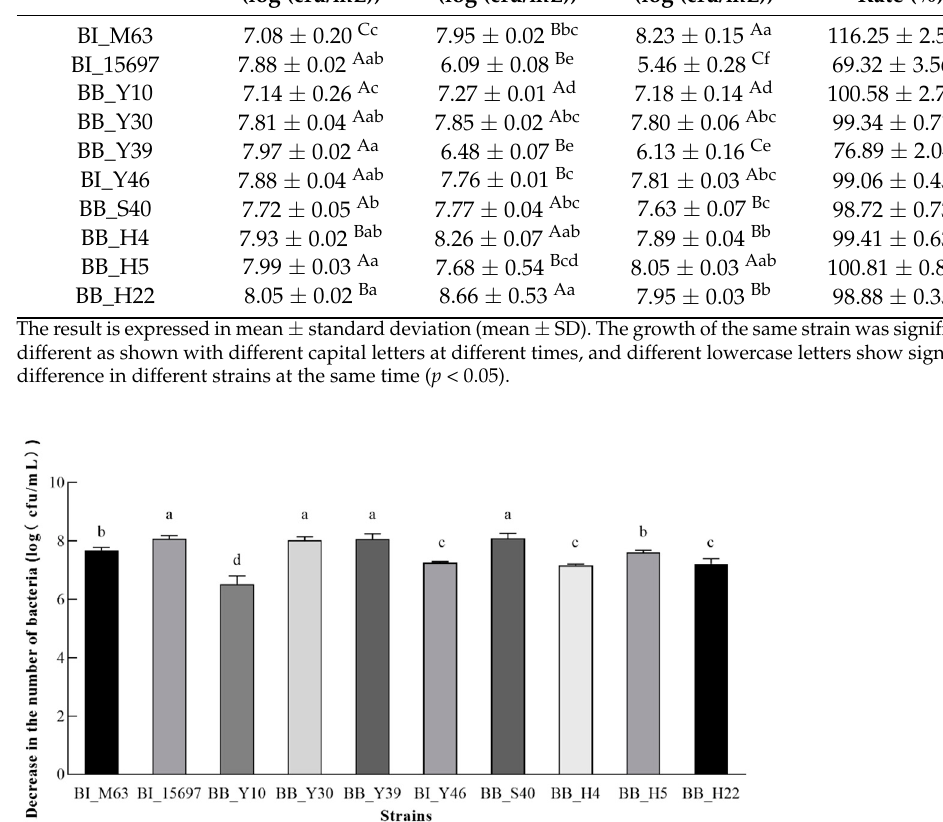
Table 2. Simulated gastric juice (pH 2.0) tolerance of screened bifidobacteria. Strains